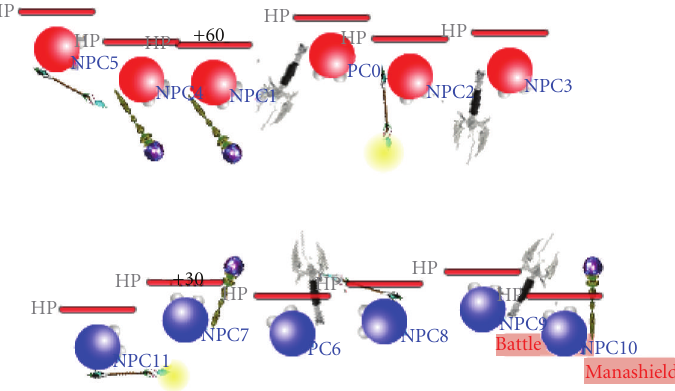
Figure 16: A screenshot of the experimental game scenario used in evaluating the TAP based on temporal links. Two teams of agents consisting of warriors, mages and priests pit against each other. They can be di ff erentiated by the weapons they carry.